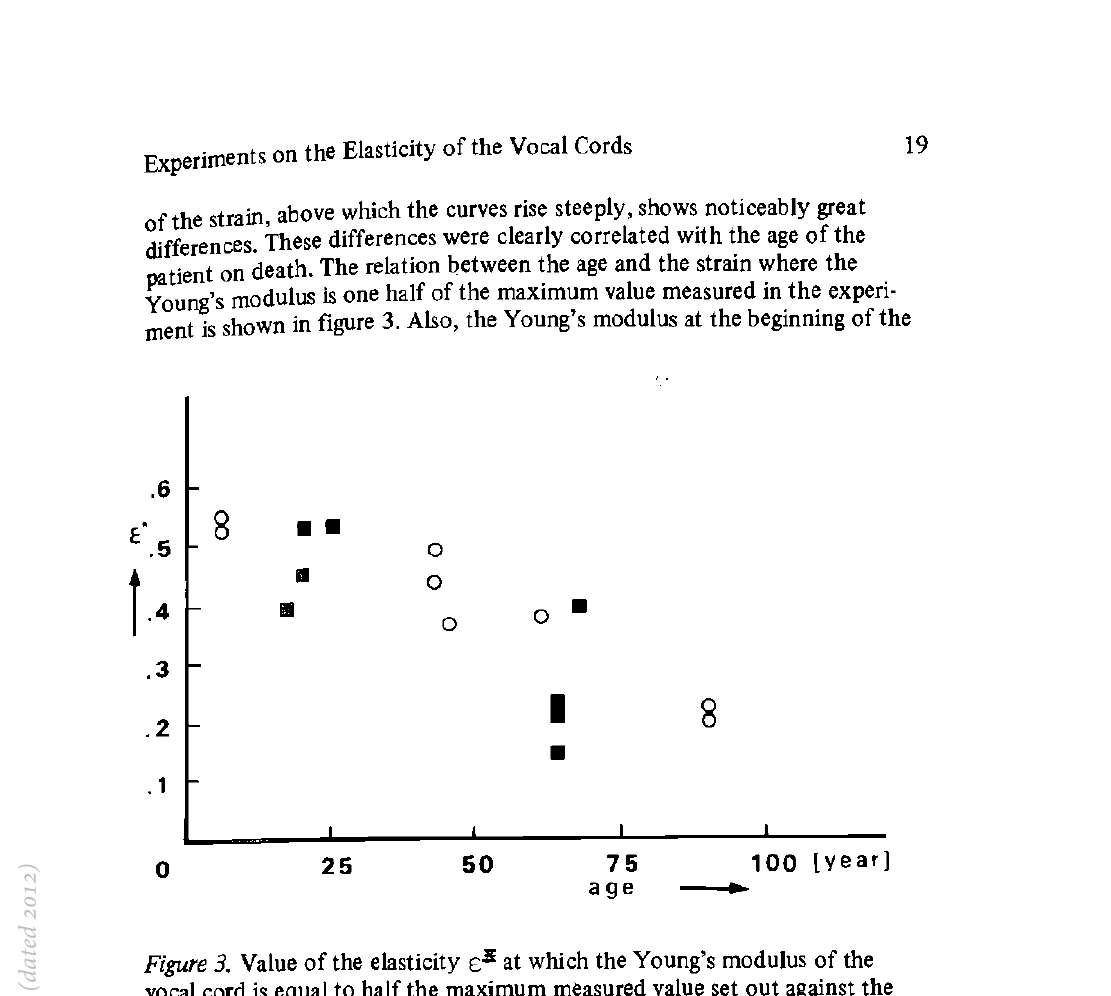
Figure 3. Value of the elasticity ε 5 at which the Young's modulus of the vocal cord is equal to half the maximum measured value set out against the age of the person at death. Shaded blocks = male, Open circles = female, Correlation co-efficient = 0.8.